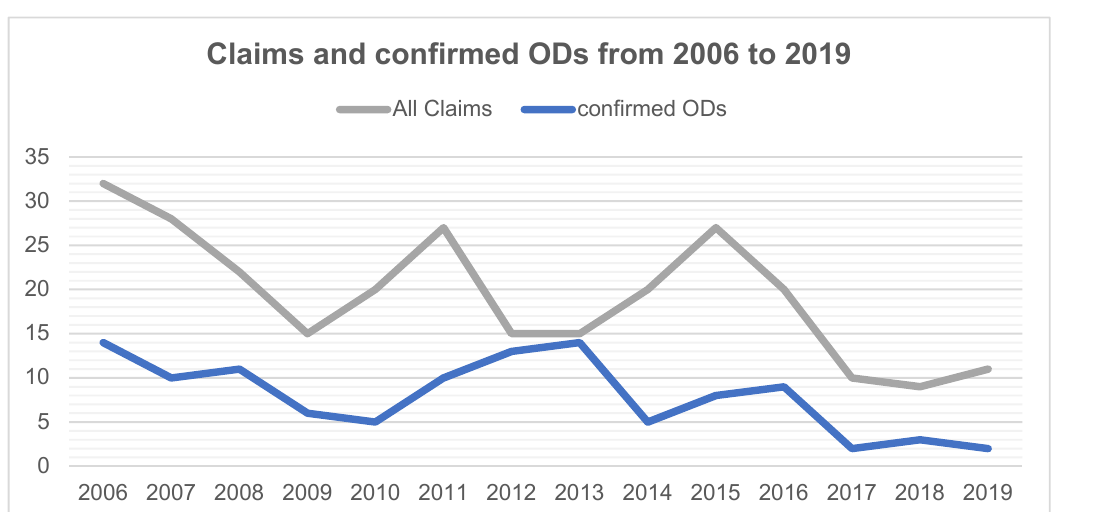
Figure 1. Number of claims and confirmed occupational diseases (ODs) among dental health workers between 2006 and